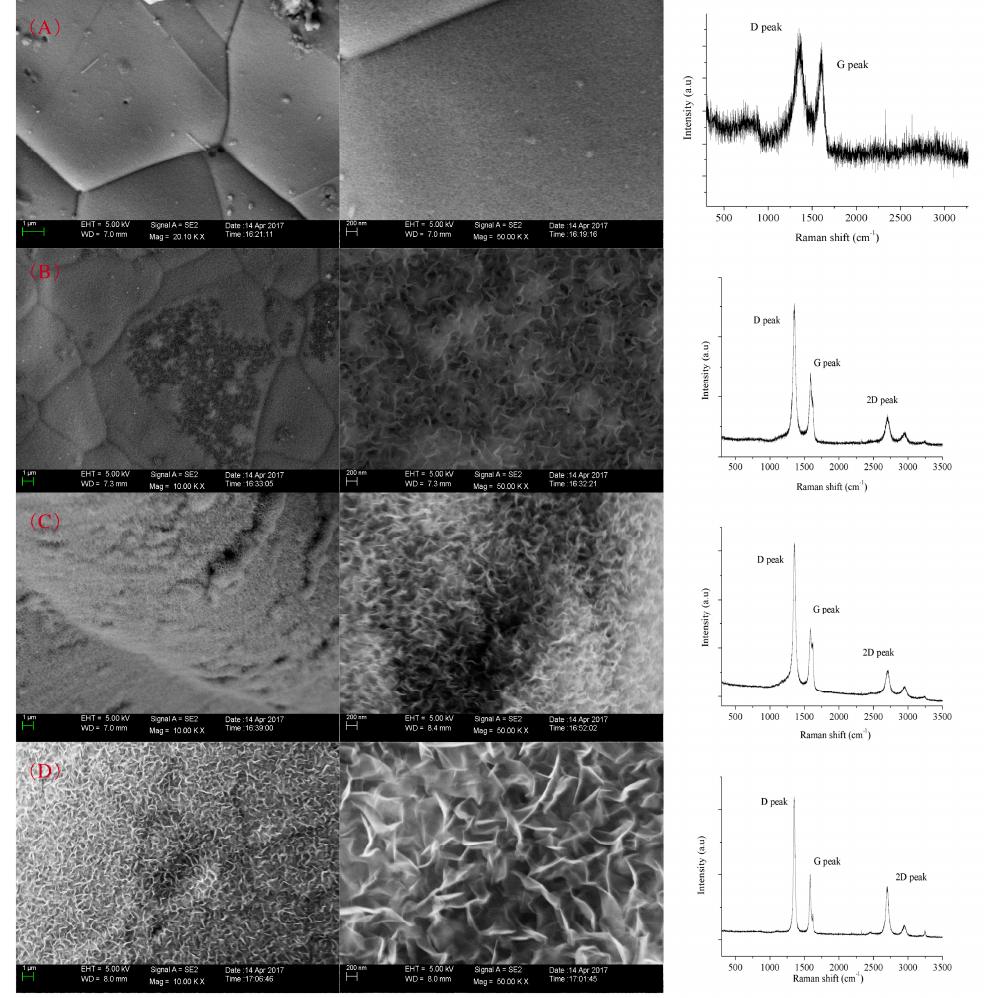
Figure 4. SEM images and Raman spectroscopy of VG sheets generated by PECVD with H 2 /Ar of ( A ) 0:25; ( B ) 5:20; ( C ) 10:15; and ( D ) 15:10. Power = 500 W, heating temperature = 800 ℃ .